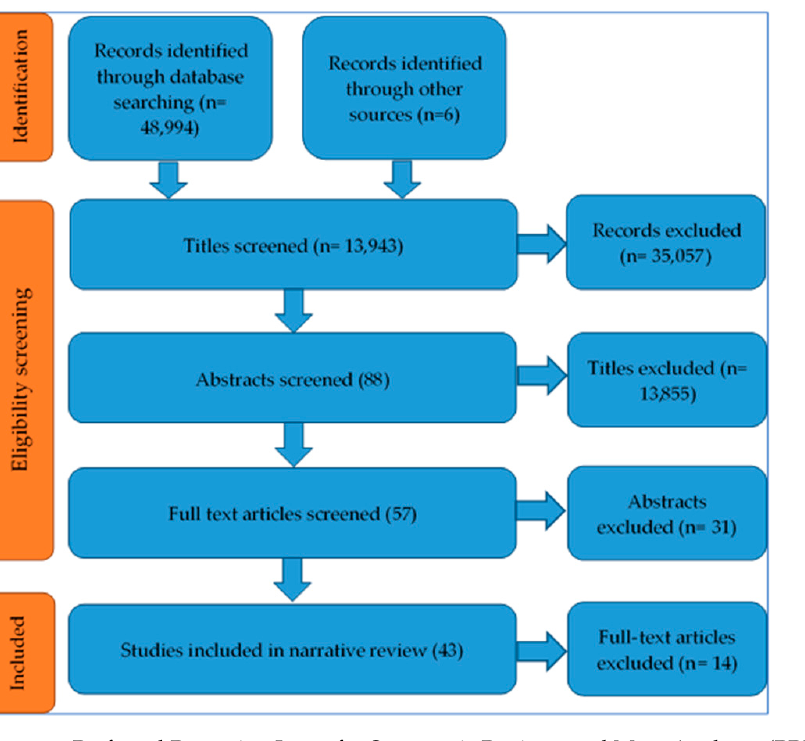
Figure 1. Preferred Reporting Items for Systematic Reviews and Meta-Analyses (PRISMA) diagram of studies included at each stage of the screening